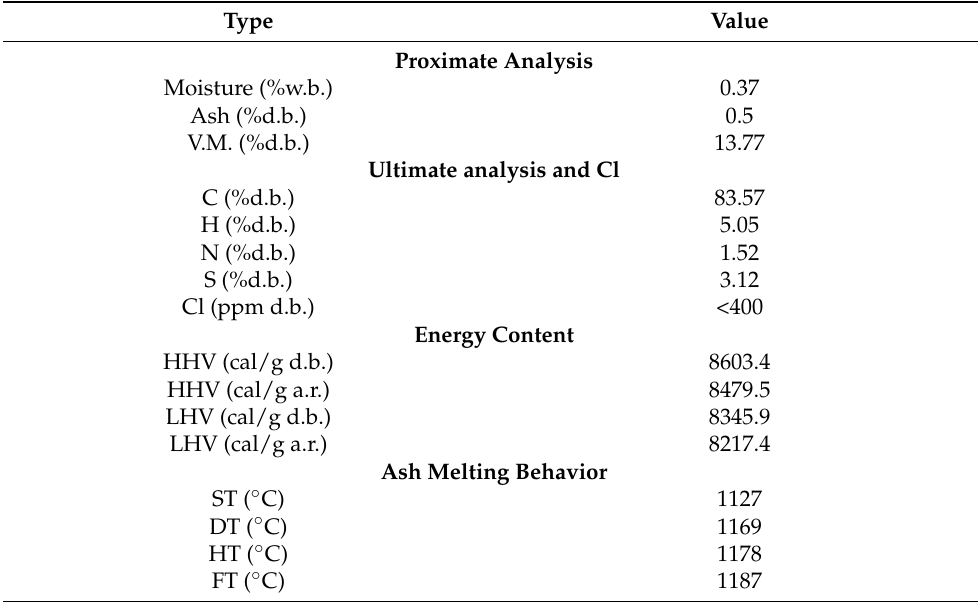
Table 8. Pet coke analysis.